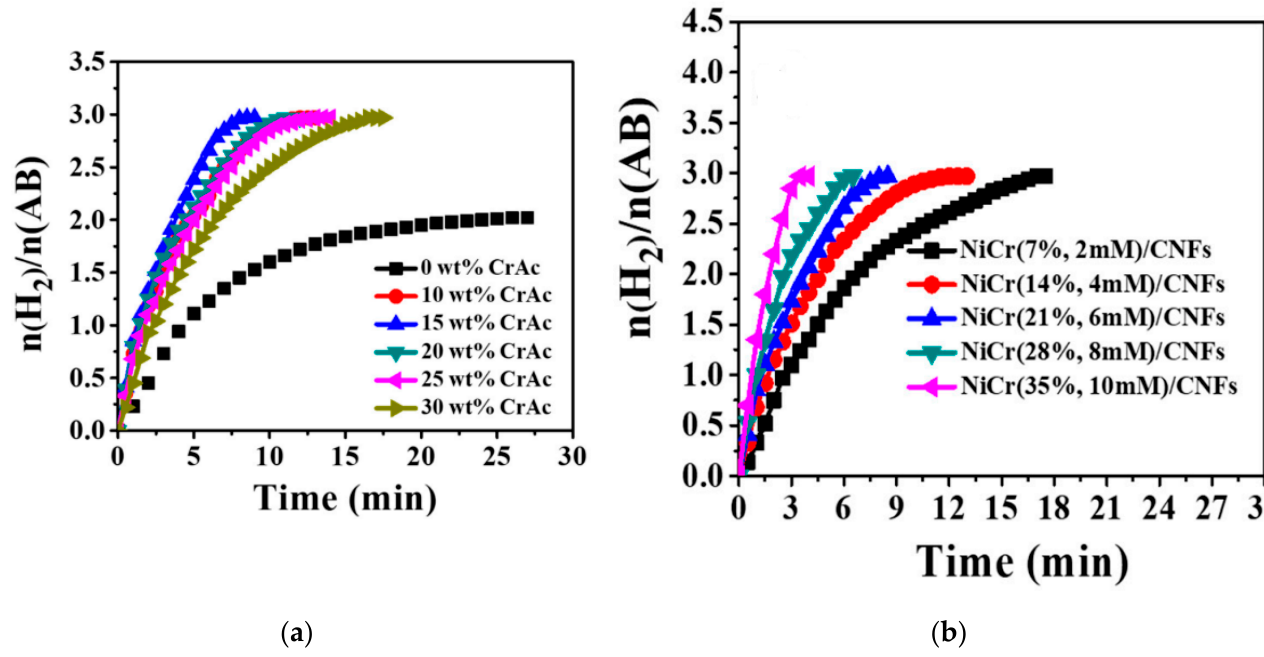
Figure 11. ( a ) Catalytic performance of Ni with different amount of Cr supported on C NFs in hydrolysis AB reaction; ( b ) Effect of metal concentration on H 2 generation. Reprinted from reference [6] with permission from MDPI.